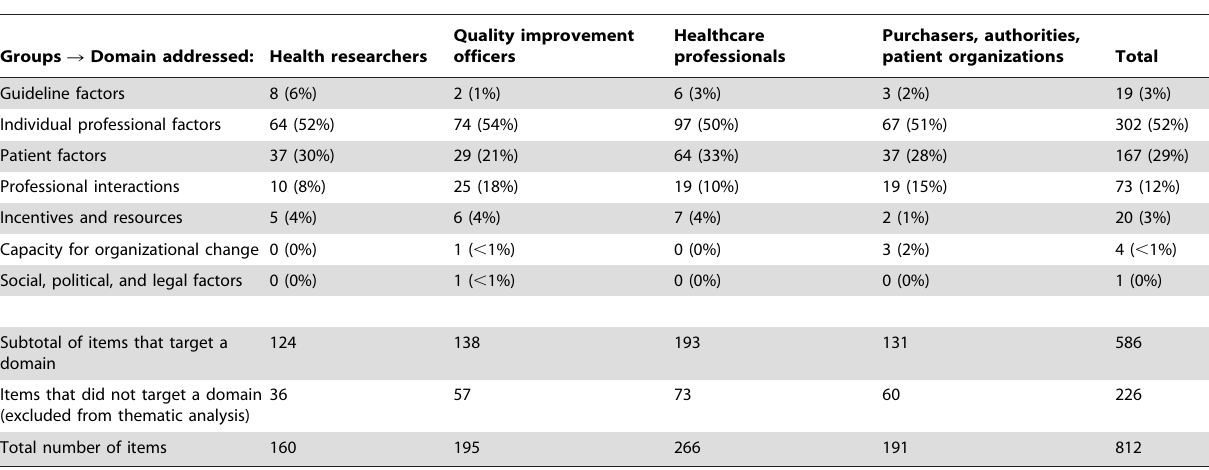
Legend. Figures refer to number of items by stakeholder group across countries (column percentages between brackets). Percentages refer to subtotal of items that targeted a